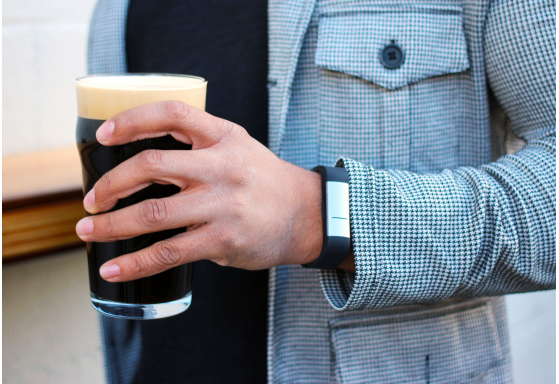
Figure 2. Photograph of the wearable alcohol sensor being worn in a real-world